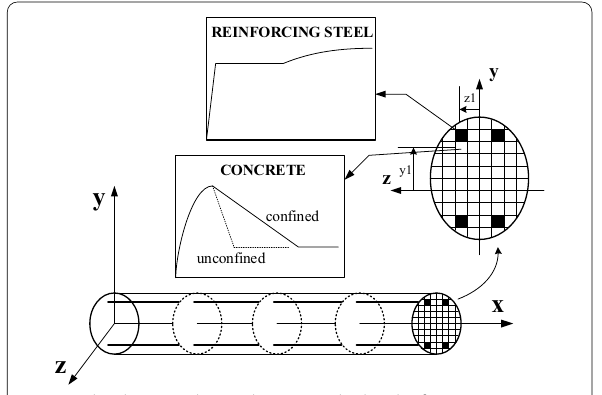
Fig. 5 Fiber beam‑column element in the local reference system.